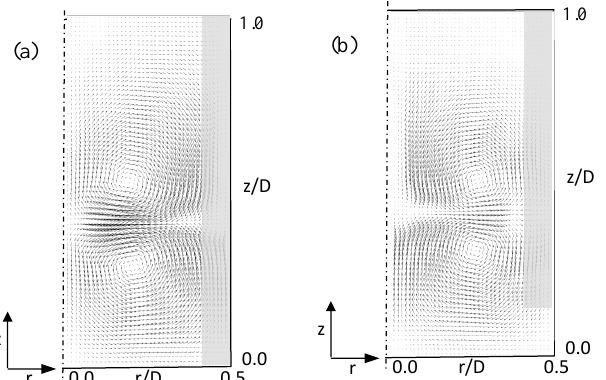
Fig. 5. Velocity field for h/H =1/3 Rushton turbine for rotational speed N =200 rpm and length of baffles : (a) L=H, (b) L=3/4H, c) L=2/3H, d) L=1/2H .